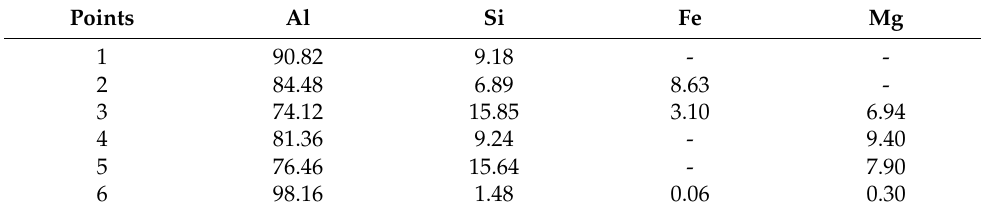
Figure 3. SEM images of Al-8Si alloy ingots ( a ) without Mg and with ( b ) 0.33% Mg, ( c ) 0.51% Mg, ( d ) 0.78% Mg, ( e ) 0.99% Mg, and ( f ) 1.32% Mg. Table 2. EDS results of the points in Figure 3. (Atomic fraction